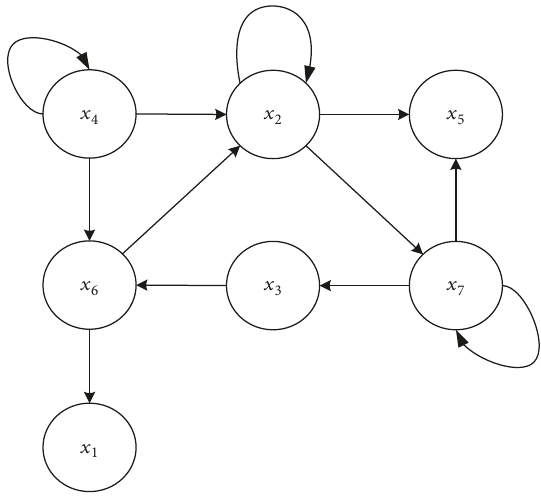
Figure 2: Structure of WNT5A gene regulatory network.